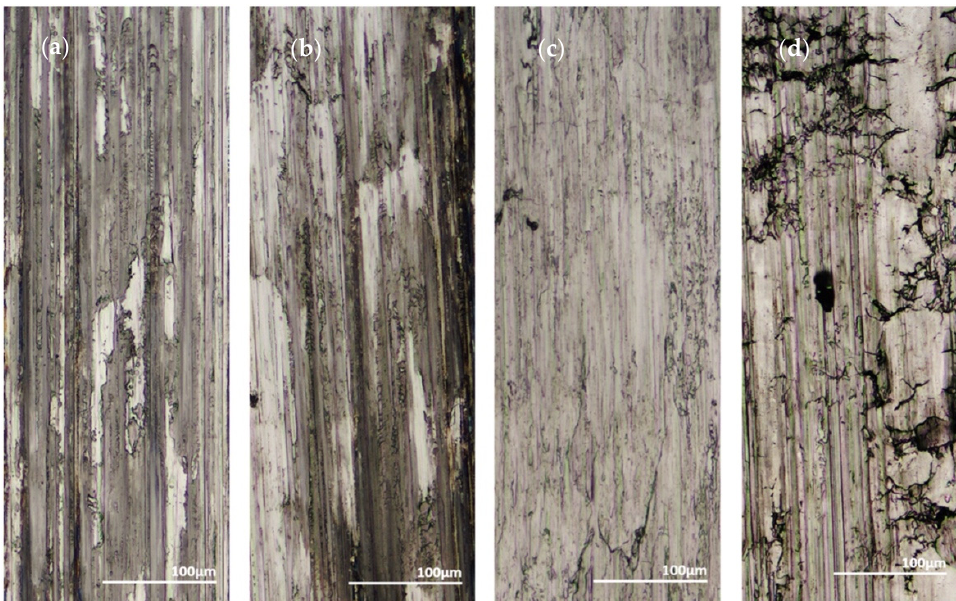
Figure 24. One hundred Passes of the Spherical Indenter on the Surface of: ( a ) 45 μ m Thick Ni-P, ( b ) 9 μ m Thick Ni-P, ( c ) 9 μ m Thick Ni-P-NiTi, ( d ) 4 μ m Thick Ni-P-NiTi.